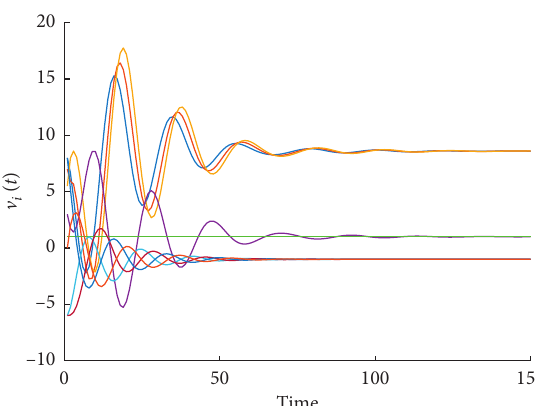
Figure 4: Dynamic multiconsensus: velocities of